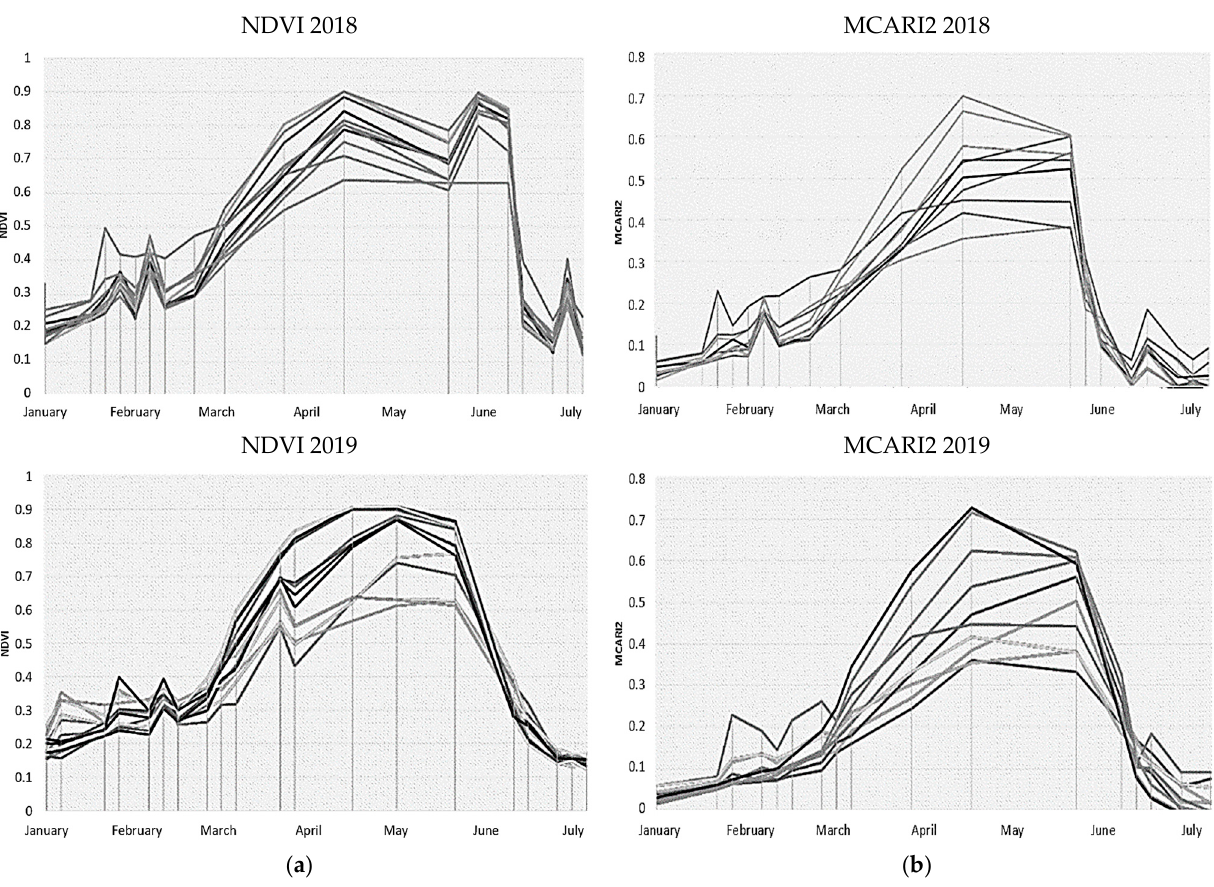
Figure 3. Average NDVI ( a ) and MCARI2 ( b ) trend of the 10 durum wheat fields in 2018 and 2019. The rise of the crop density and the variation of the photosynthetic activity values increased the standard deviation among the measured values. A consistent increase in values for both vegetation indices was observed during the stem elongation phase up to the flowering phase, when the curves reached a plateau, due to the complete coverage of the soil surface, from the end of March to the beginning of May. The MCARI2 index showed a higher standard deviation during this phase than the NDVI index, while during the grain filling period, the NDVI lost sensitivity in the estimation of vegetation cover, resulting in a higher standard deviation than MCARI2. This confirmed a previous study [35] showing the loss of sensitivity of the NDVI for values of LAI greater than 3 and, the greater potential of MCARI 2 for estimating LAI and biomass. The decrease in the values of the vegetation indices at the end of the season was attributed to the senescence of the leaves which increased the reflectance of the red band and decreased the reflectance of the NIR